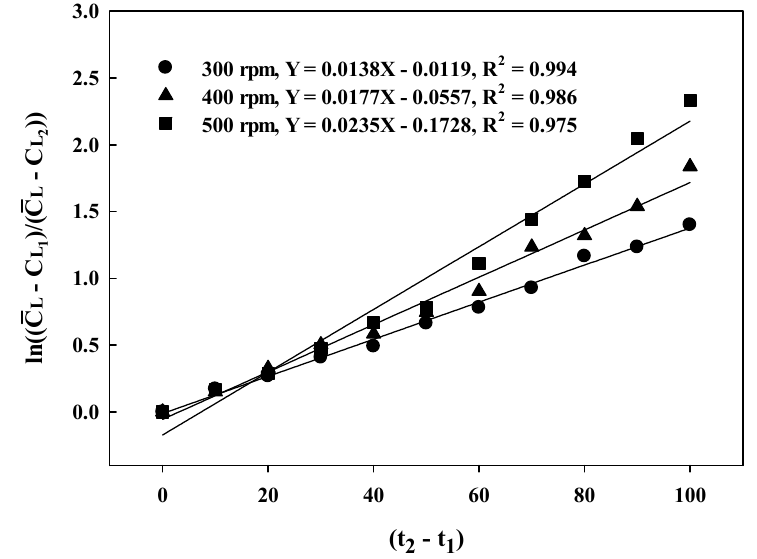
Figure 3. The volumetric mass transfer coefficient, K L a , depends on agitation speed.